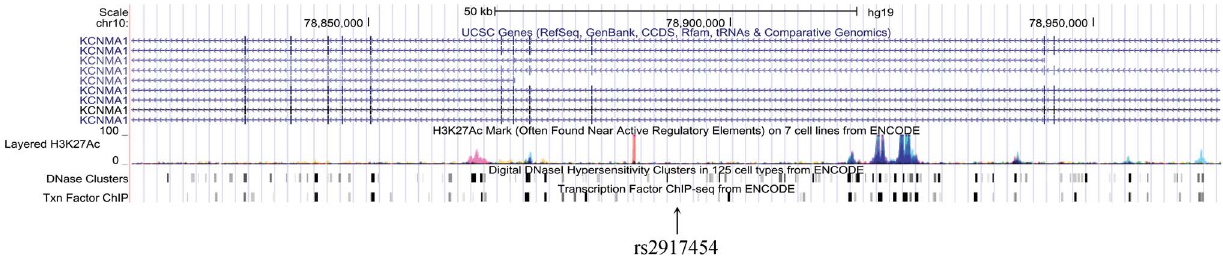
Figure 1. H3K27ac marks representing active regulatory elements found near the locus of rs2917454 in gene KCNMA1 .